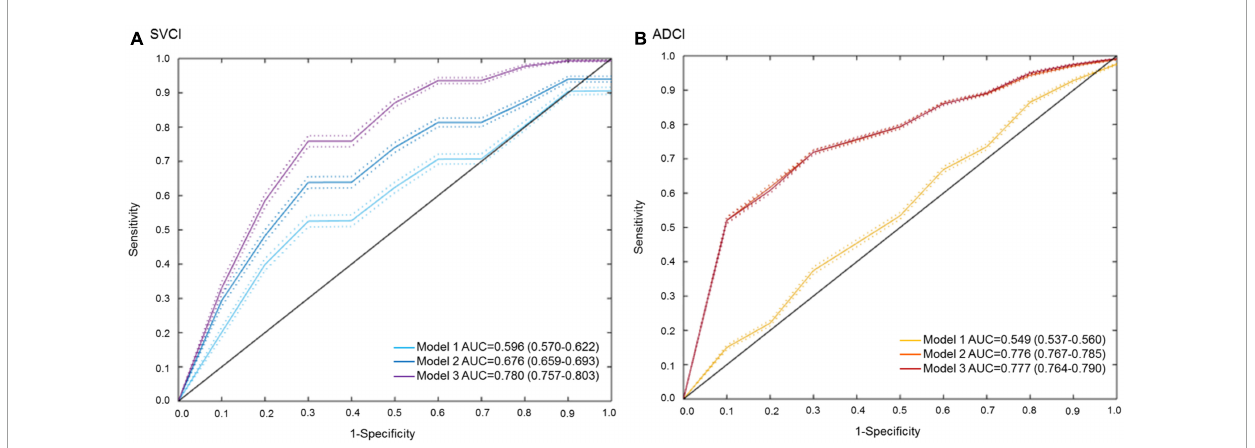
FIGURE4 ROC curves for the prediction of A β positivity. (A) SVCI. (B) ADCI. Solid lines indicate the mean AUC and dotted lines indicate the 95% CIs of the AUC. Each model was developed by multivariable logistic regression. Model 1: A β positivity ∼ clinical factors (sex, age, and education). Model 2: A β positivity ∼ clinical factor + APOE ∈ 4. Model 3: A β positivity ∼ clinical factor + APOE ∈ 4 + rs4732728. A β , amyloid beta; ADCI, Alzheimer’s disease-related cognitive impairment; AUC, area under the receiver operating characteristic curve; CI, confidence interval; ROC, receiver operating characteristic; SVCI, subcortical vascular cognitive